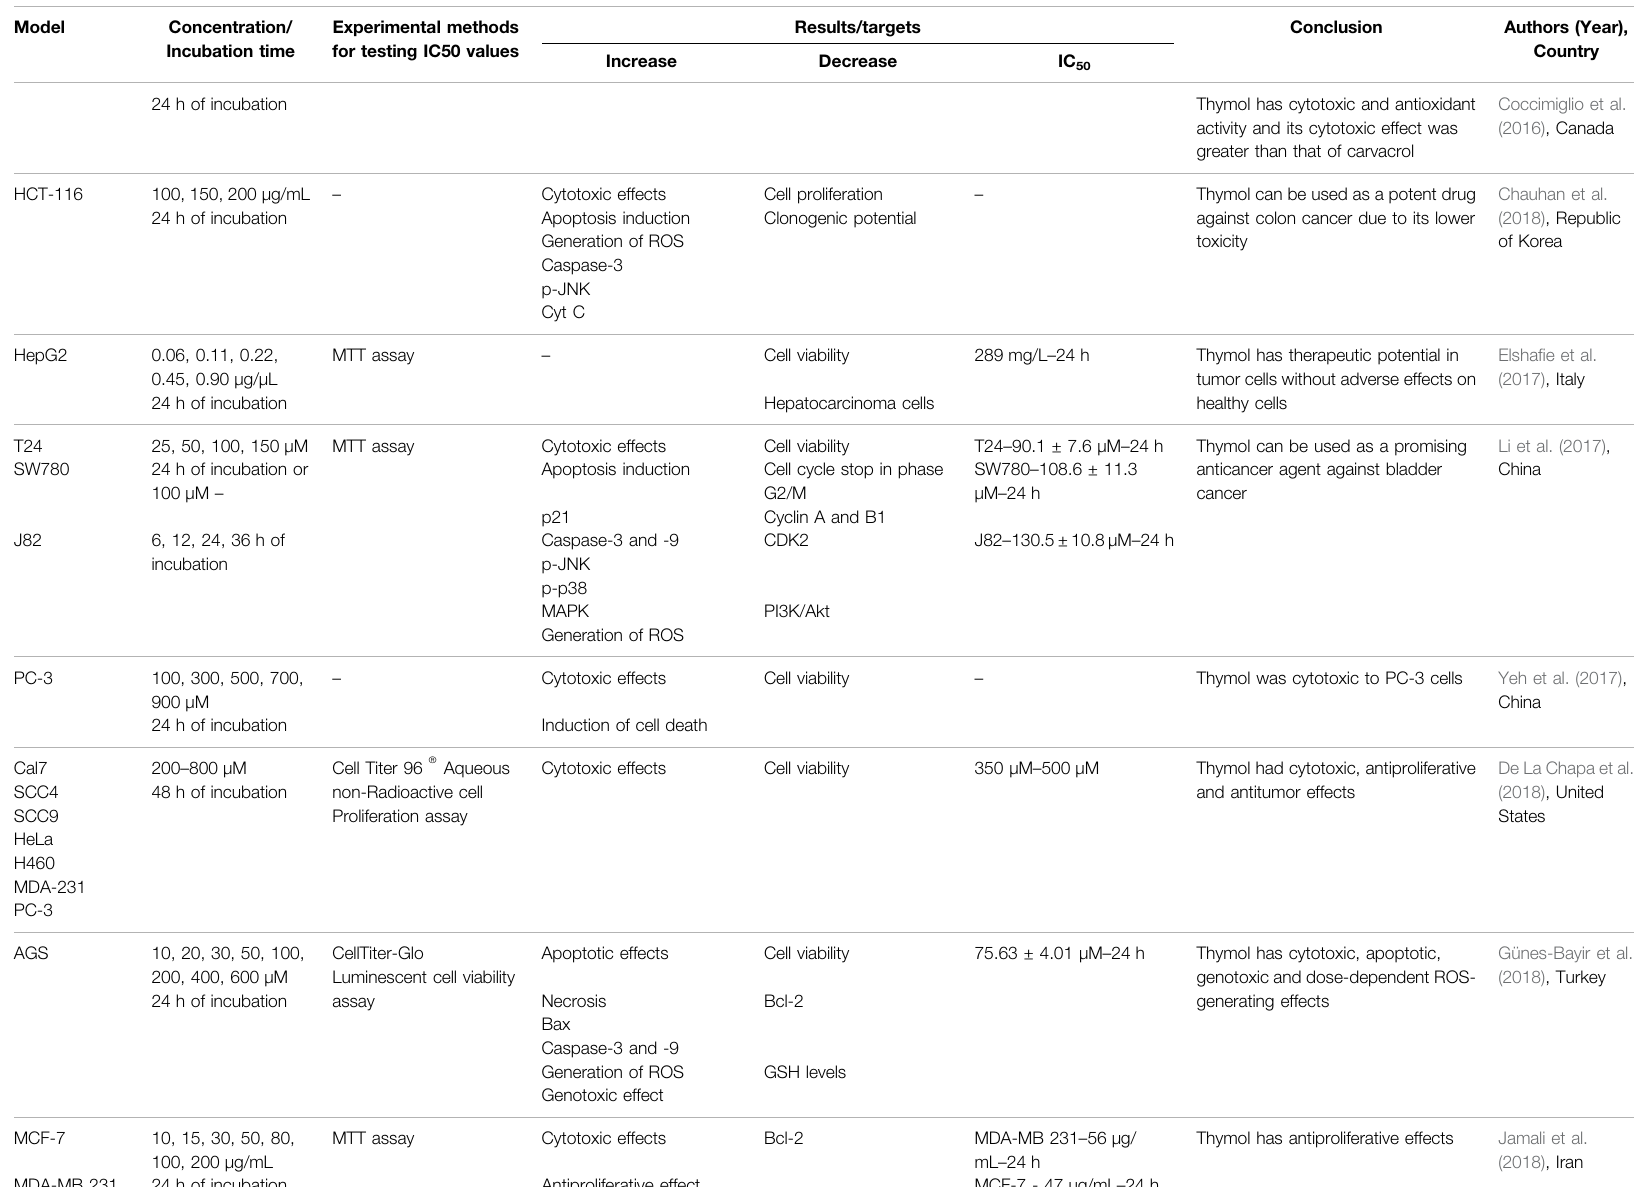
TABLE 2 | ( Continued ) Detailed description of the studies that used thymol, included in the systematic